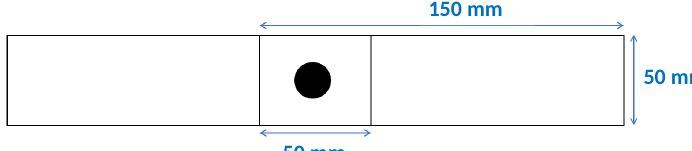
Figure 2. Tensile-shear specimen.